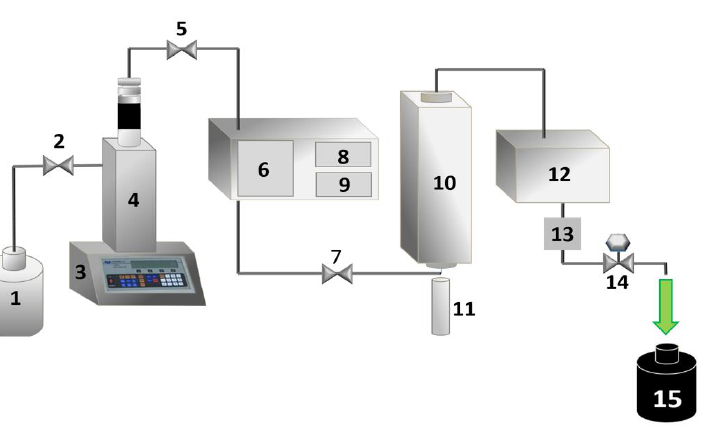
Figure 1. Experimental apparatus for pressurized liquid extraction: (1) solvent reservoir (80% v / v ethanol/purified water), (2) needle valve, (3) syringe pump controller, (4) syringe pump, (5) needle valve, (6) preheater, (7) needle valve, (8) preheater temperature controller, (9) extractor vessel temperature controller, (10) extractor vessel, (11) extraction cell with 4.0 g of Tetragonia tetragonoides (diameter of 1.30 cm and height of 18 cm), (12) cooling system, (13) pressure indicator, (14) “back pressure” valve, and (15) extract collector bottle.